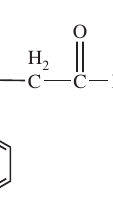
Figure 1: Structure of (C